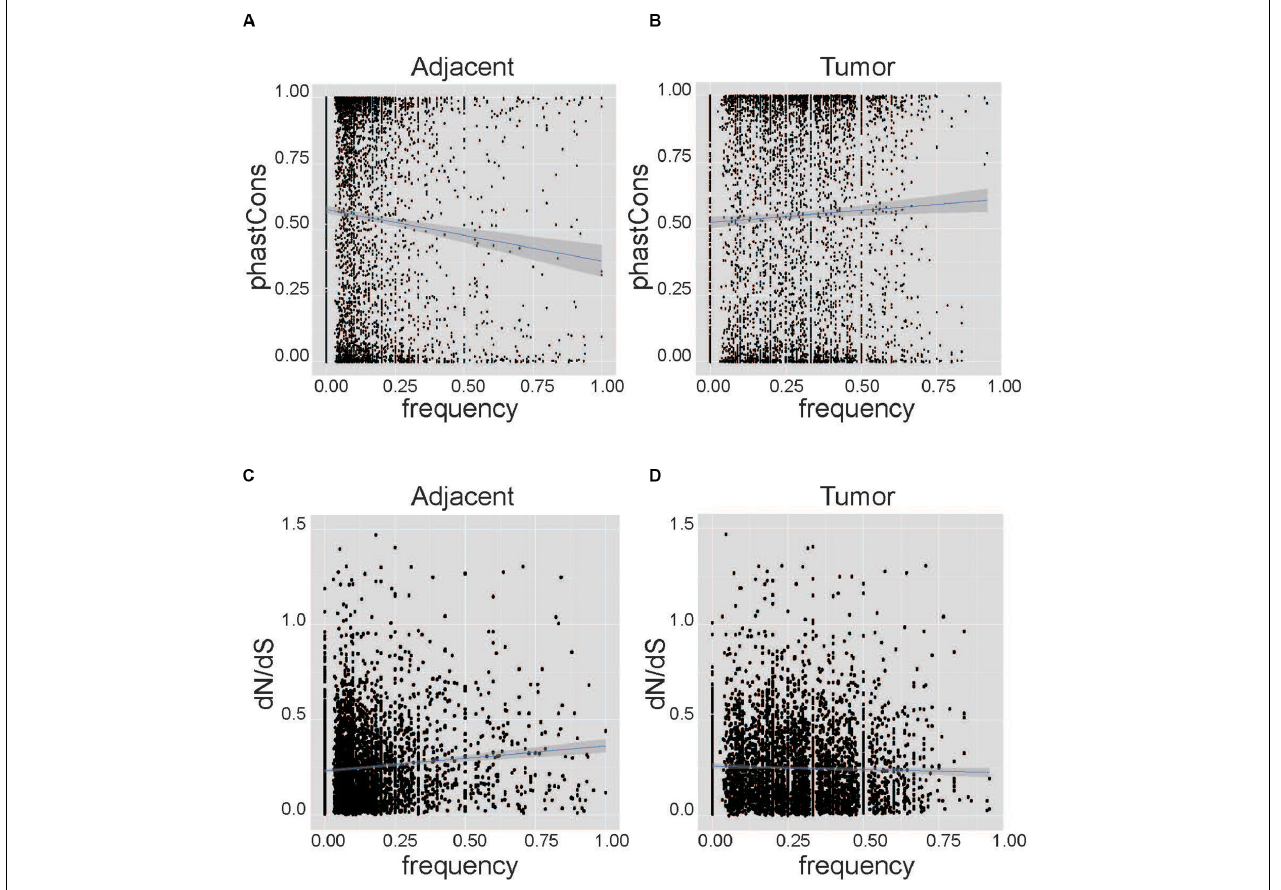
FIGURE 2 | Correlation analysis between conservation and the frequency of AEI at the nucleotide level. The horizontal axis represents the frequency of AEI in the gene in the patient sample, and the vertical axis represents conservation using the PhastCons score and dN/dS. (A) The correlation analysis for adjacent tissues shows that sites with higher conservation scores tend to have lower frequencies of AEI (Cor = –0.08, p- value = 1 . 97 E − 8 ). (B) The correlation analysis for cancer tissues shows that more conservative sites tend to have higher frequencies of AEI (Cor = 0.04, p- value = 0.00604). (C) The correlation analysis for adjacent tissues shows that genes with higher frequencies of AEI also have higher dN/dS (Cor = 0.11, p -value = 4 . 34 E − 13 ). (D) A correlation between dN/dS and the frequency of AEI in tumor tissues could not be observed (Cor = –0.02, p- value =